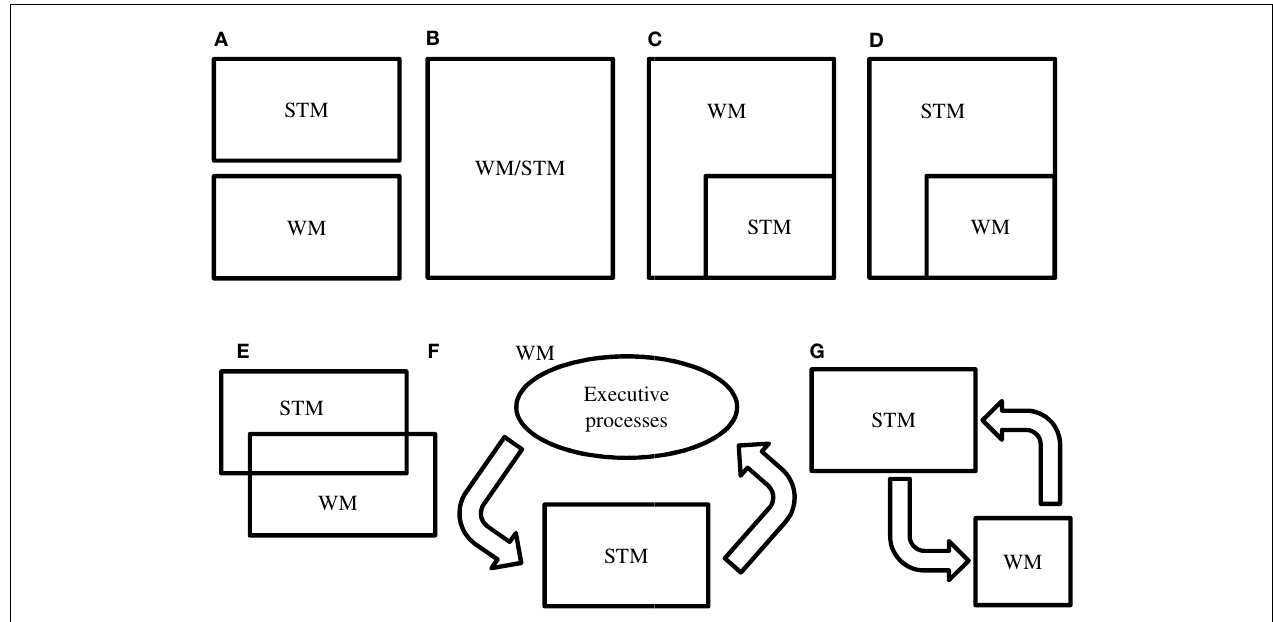
(or vice versa) either. Model (F) proposes thatWM is STM plus additional processes.This model fits the models of Baddeley and Cowan in